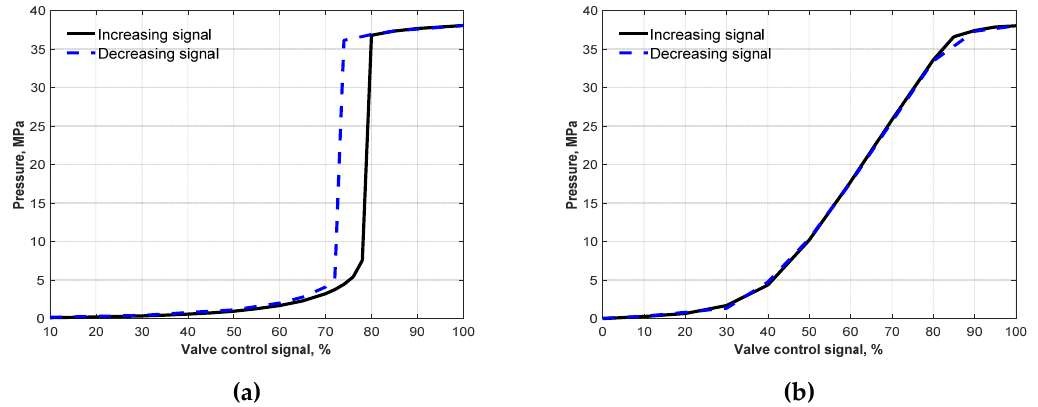
Figure 9. Static description of control valve: ( a ) original, before negative feedback occurs, ( b ) after negative feedback and linearization.